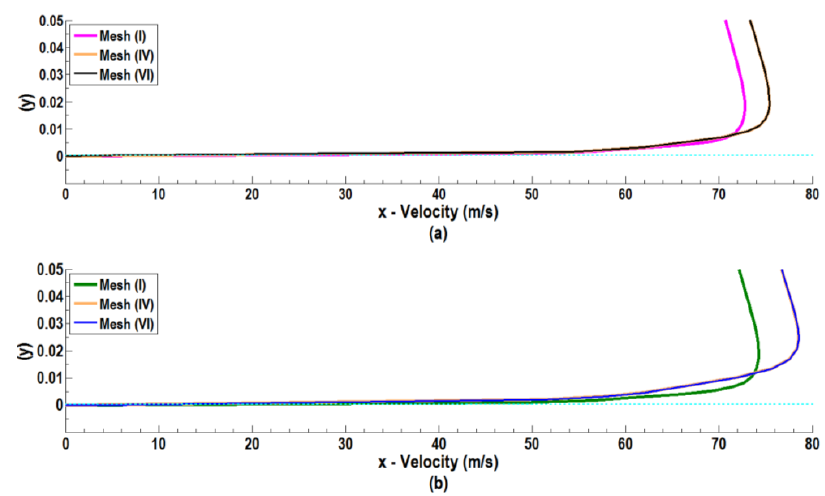
Figure 5. Velocity profiles on the upper surface of airfoil at a 20% cord location from the leading edge at α = 12° and δ = 0° and for ( a ) Re = 10 5 and ( b ) Re = 10 6 .